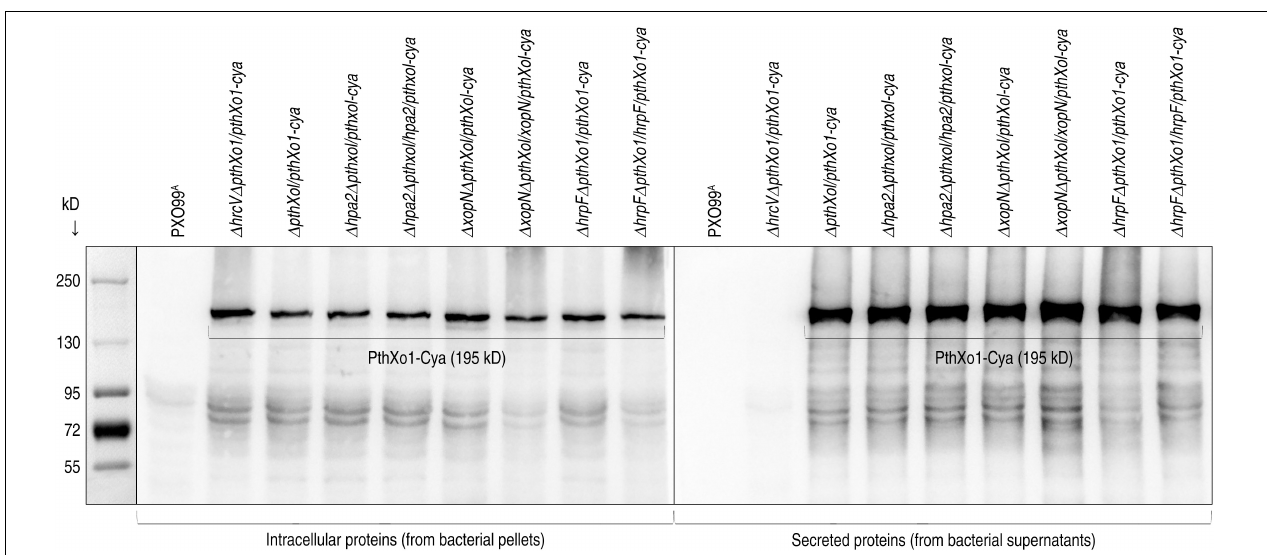
FIGURE 3 | PthXo1 secretion by PXO99 A and mutants defected in hpa1 , hpa2 , hrpF , or hrcV . The PthXo1 protein was fused to a Cya sequence and introduced in the fusion form into bacteria of the PXO99 A mutants. Bacterial cultures of PXO99 A and the mutants were used to isolate soluble proteins. Protein samples were analyzed by immunoblotting with the specific antibody against